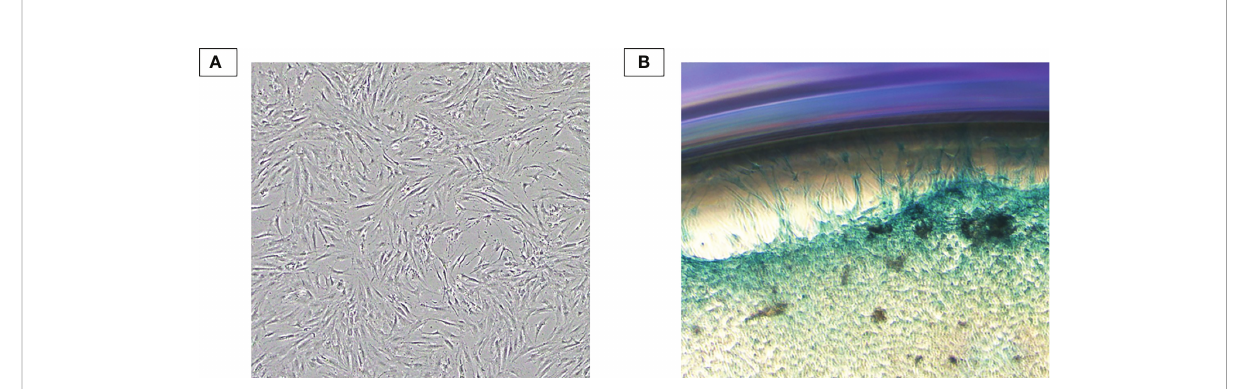
FIGURE 3 Chondrocyte characterization. (A) Human primary chondrocytes isolated from the human knee articular cartilage tissue at P1. Isolated cells exhibited typical morphology of primary chondrocytes: fl attened and polygonal shape. (B) Alcian Blue staining result. Isolated cells were subjected to form colony and positive with Alcian Blue staining dye – an indicator of proteoglycan